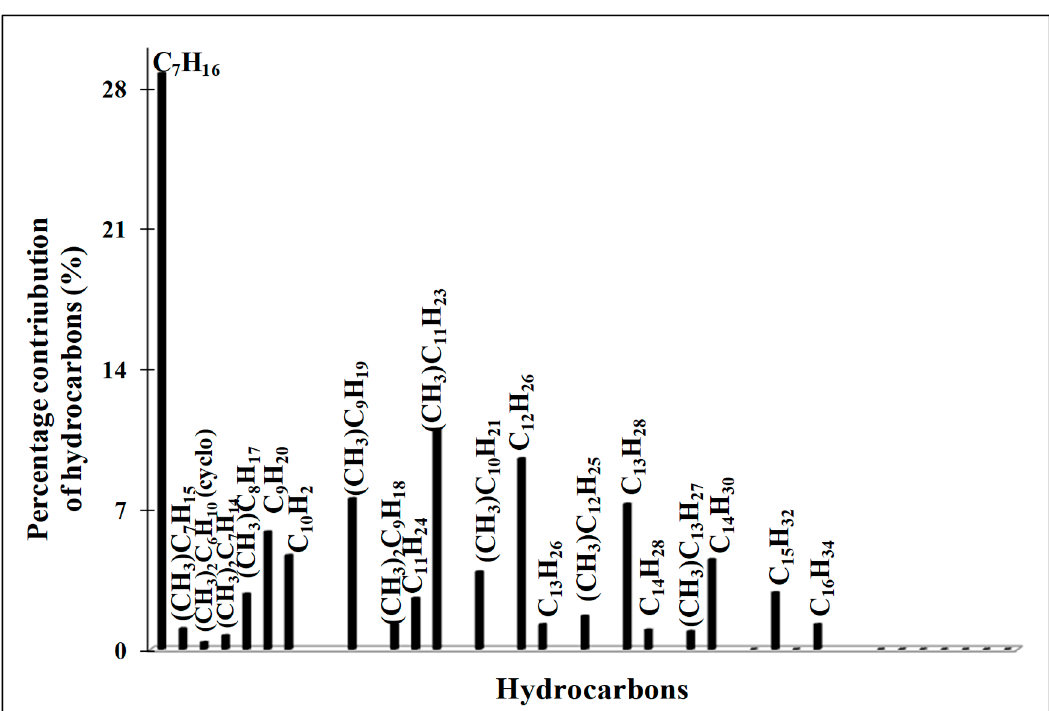
Figure 8. GC–MS analysis of liquid products obtained in FTS on Red-C-Co 5.0 SiBEA catalyst reduced at 500 °C in 100% H 2 flow.